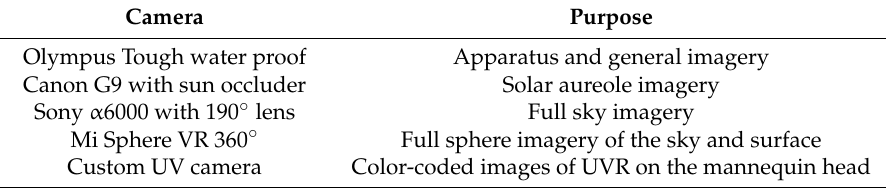
Table 6. Cameras used in the UVI survey and their principle purposes.